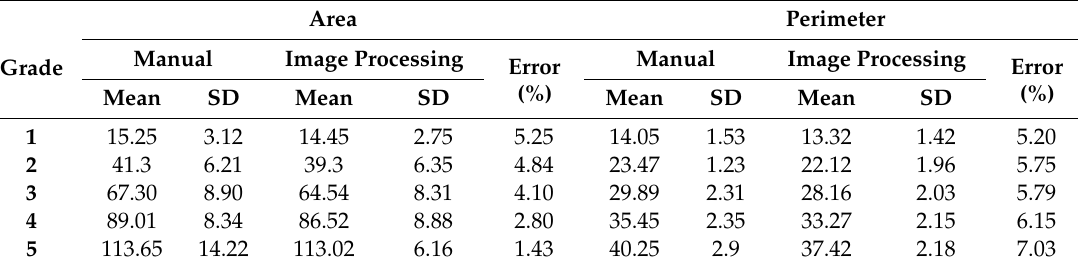
Figure 13. Software implementation system for the leaf: ( a ) Grade 1 and ( b ) grade 5. Table 5. Mean of area and perimeter for five grades.